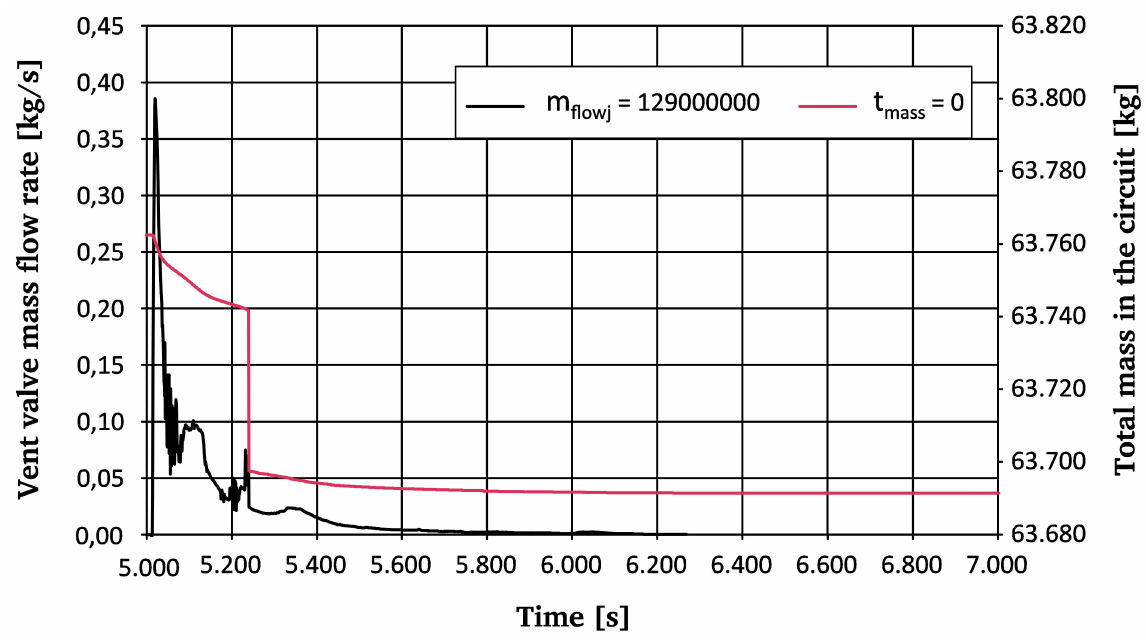
Figure 3. Vent valve mass flow rate and total mass flow in the circuit